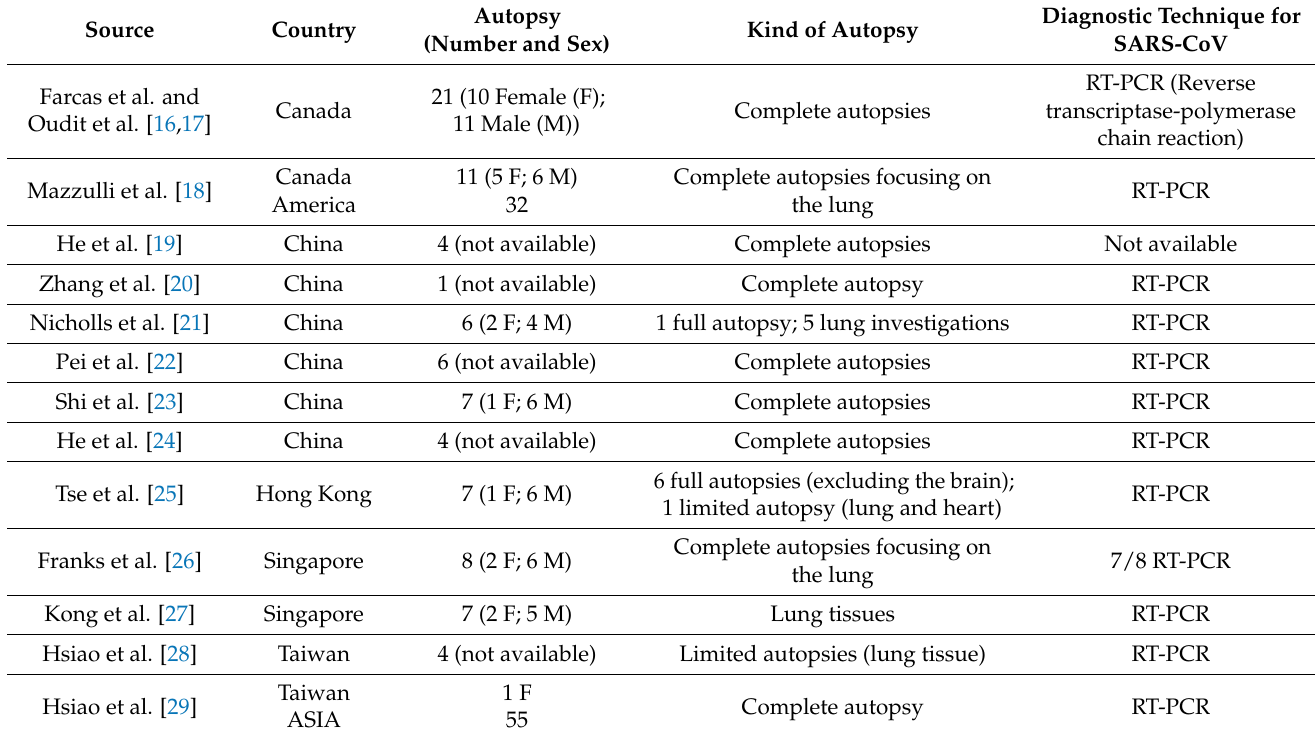
Table 1. General data obtained analyzing the studies included in this literature review matching the keywords “Autopsy” OR “Post-mortem” AND “SARS-CoV” (severe acute respiratory syndrome